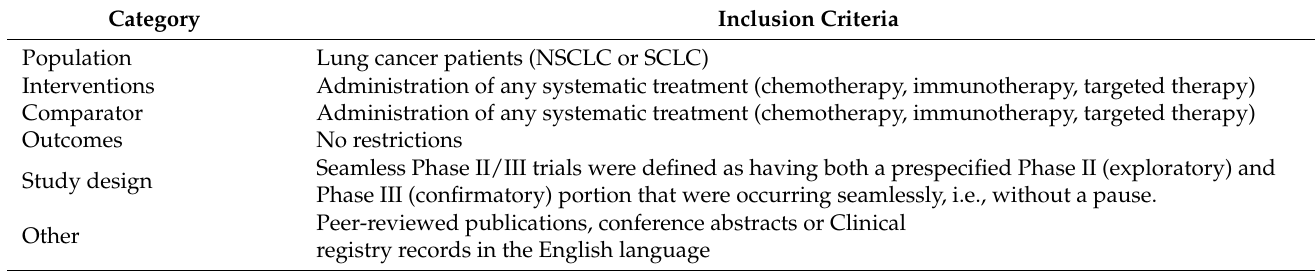
Table 1. Summary of PICOS (population, intervention, comparator, outcomes, study design)